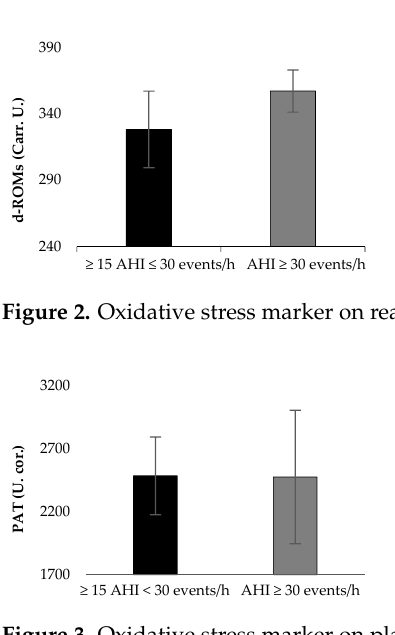
Figure 1. Correlation analysis results between apnea hypopnea index (AHI) and reactive oxygen metabolites’ levels (d-ROM) ( a ), chest circumference difference between maximal inhalation and exhalation ( Δ chest) ( b ), neck circumference ( c ), meters during 6 min walk test (6MWT) ( d ), estimated oxygen uptake (VO 2 ) ( e ), metabolic equivalent (MET) ( f ) and dyspnea at the end of 6MWT ( g ).